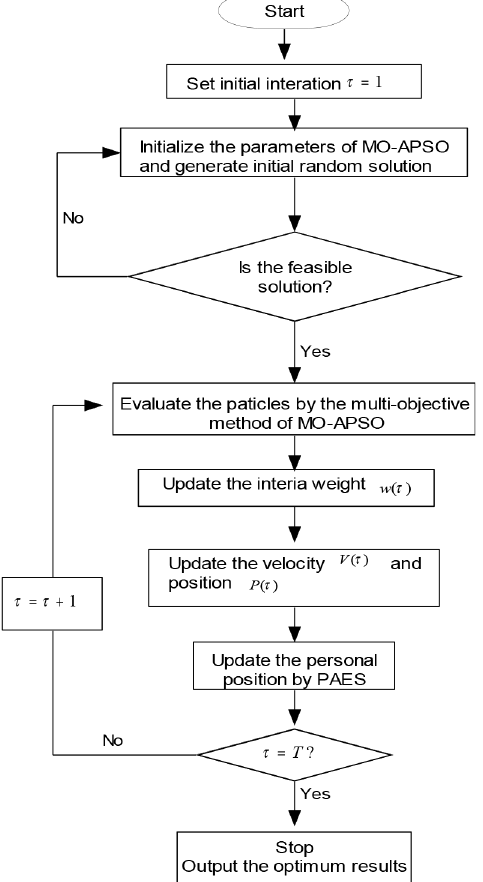
Figure 6. The procedure of